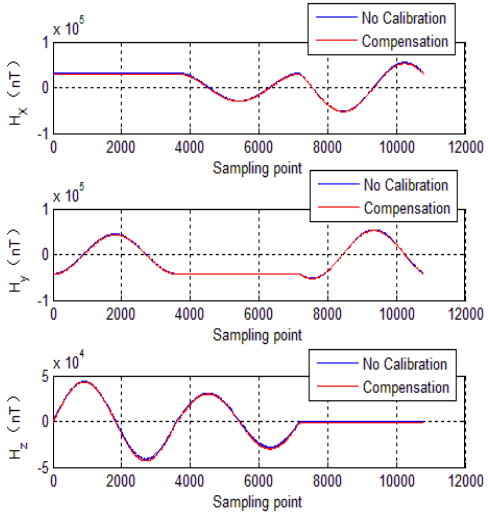
Figure 12. Magnetometer measured outputs.